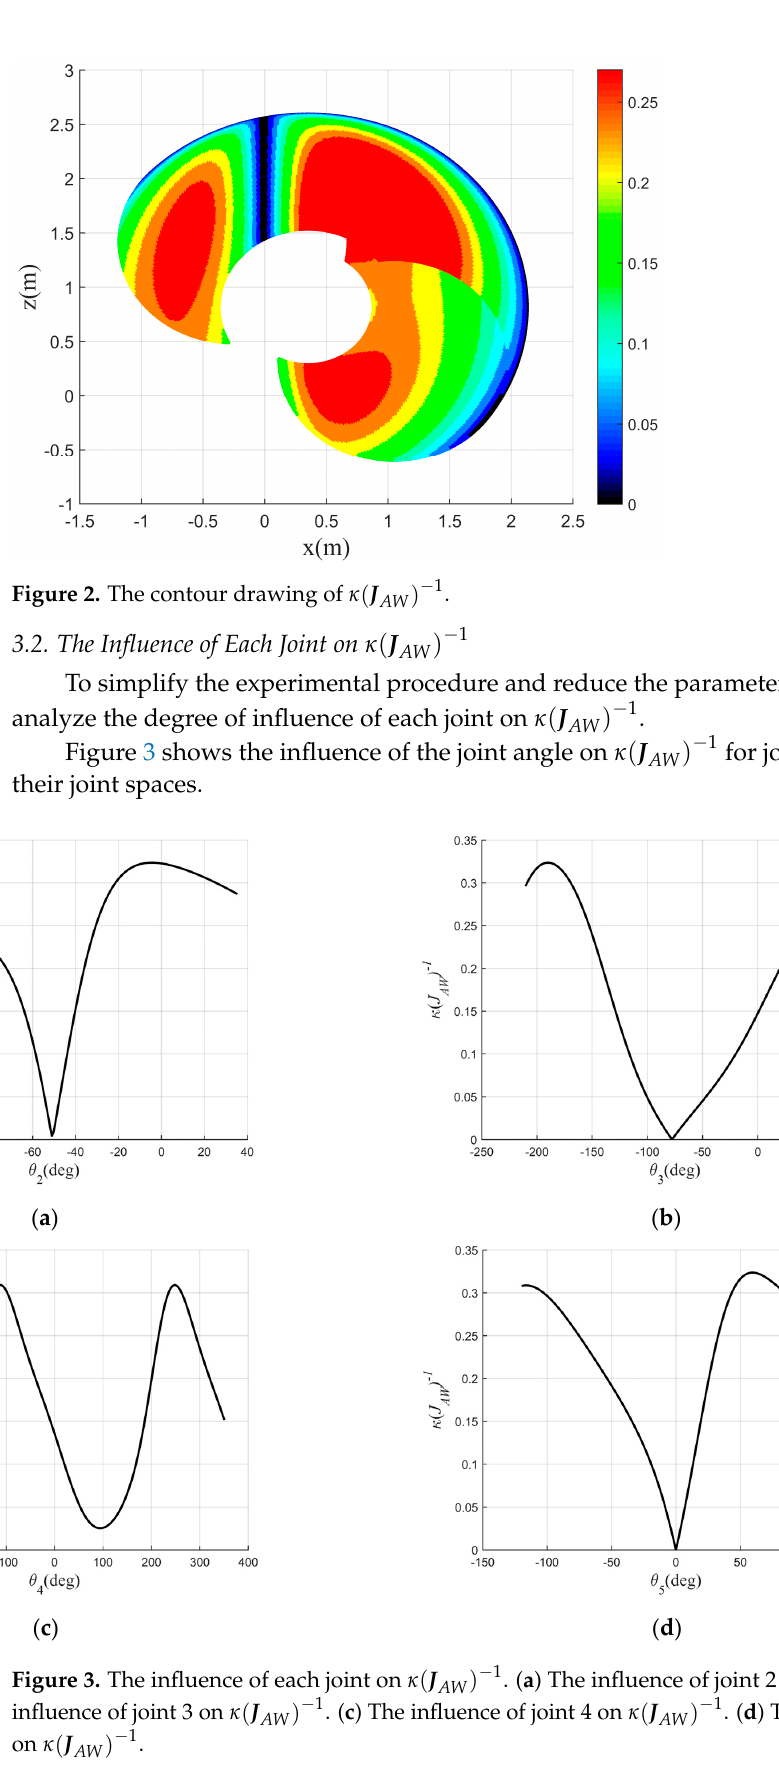
Figure 3. The in fl uence of each joint on Figure 3. The influence of each joint on κ influence of joint 3 on κ ( J AW ) − 1 . ( c ) The influence of joint 4 on κ ( J AW ) − 1 . ( d ) The influence of joint 5 on κ ( J AW ) − 1